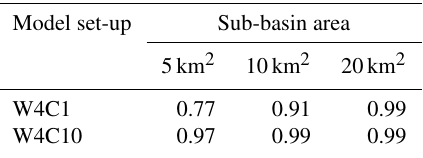
Table 3. Mean value of the Nash-Sutcliffe efficiency (NSE) of the comparison between W4C1 and W4C10 TOPMELT-ICHYMOD- simulated flows and the reference flow simulations, obtained by us- ing the W4C20 set-up, over basins of three different drainage areas: 5, 10 and 20km 2 . Comparisons were carried out over the 1 March to 30 June